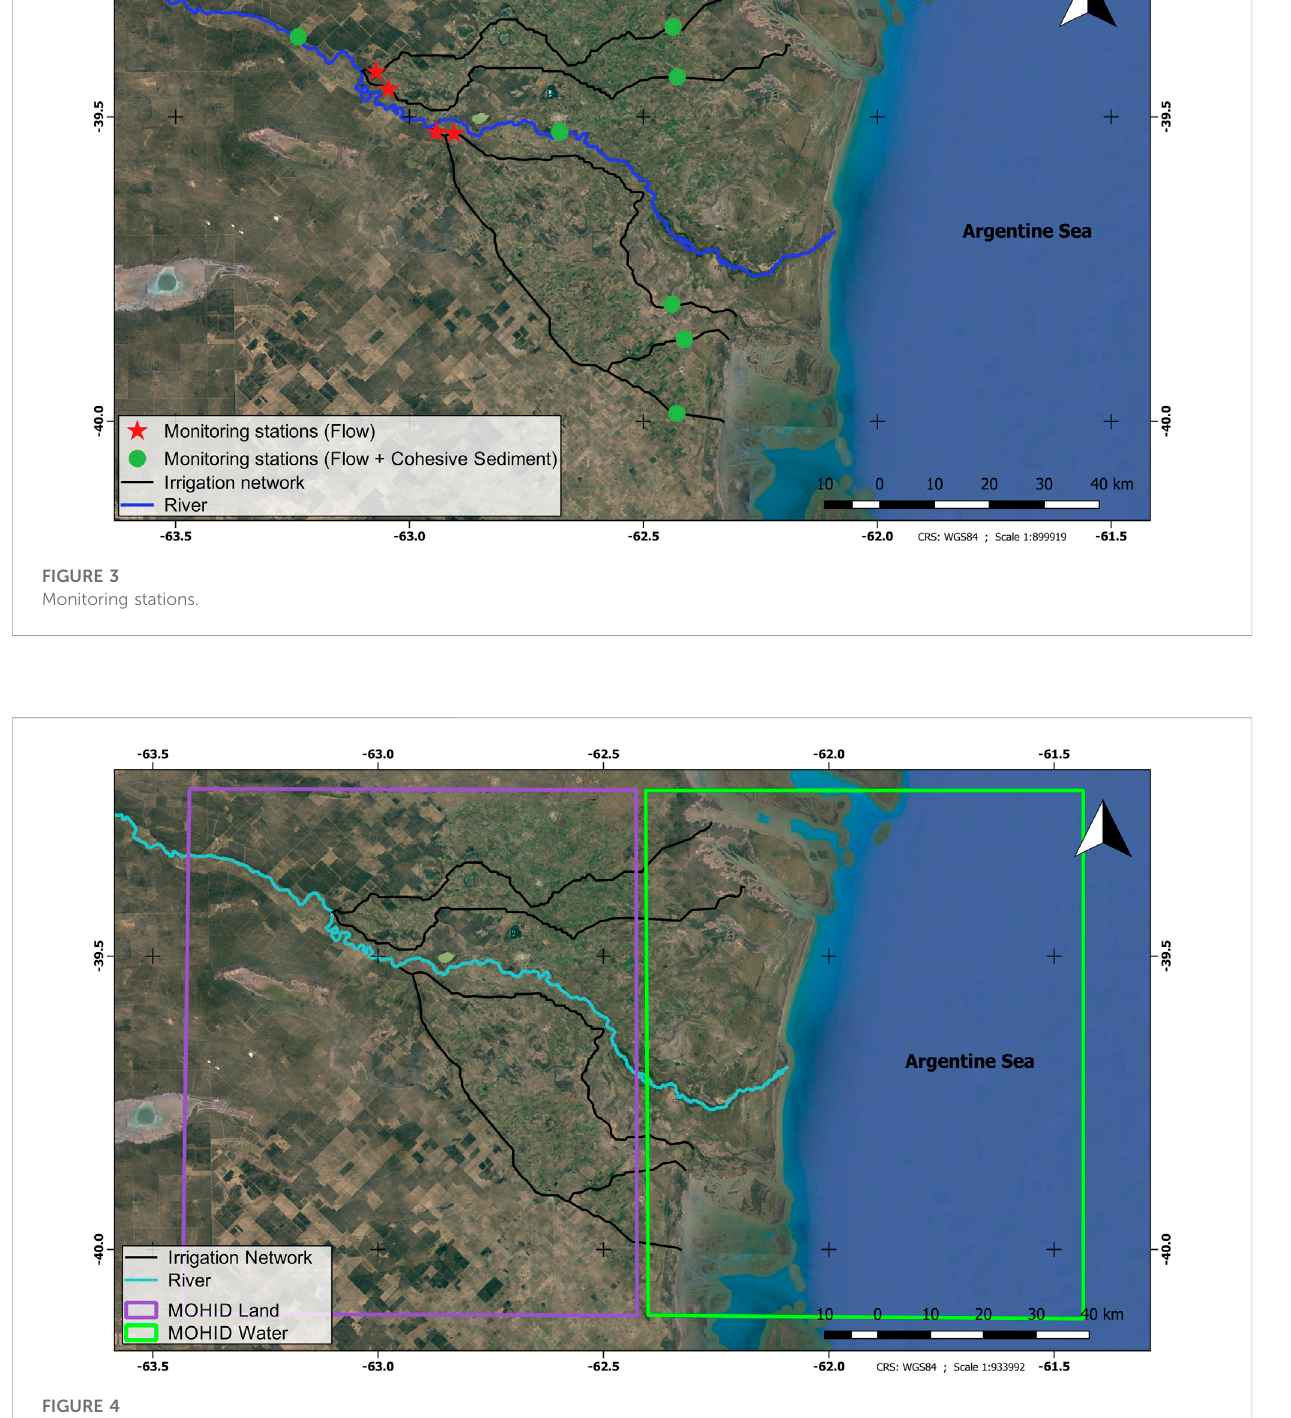
simulated but provides data necessary for imposing surface boundary conditions, the water moves through the remaining mediums based on mass and momentum conservation equations